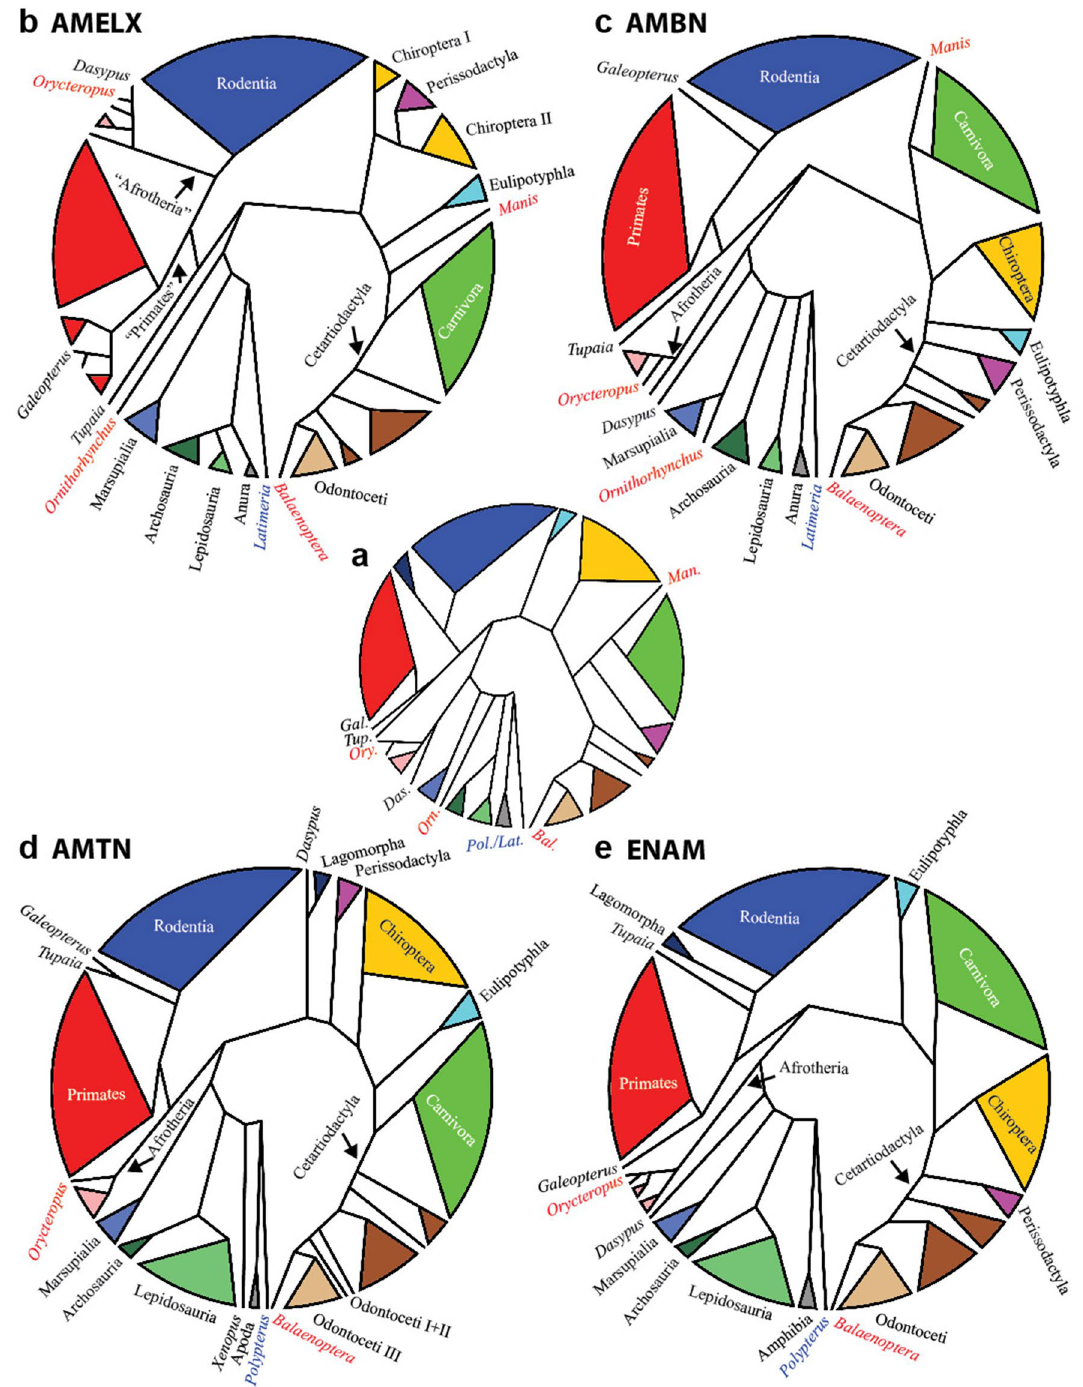
Figure 1. Schemes of unrooted, majority consensus trees of four major enamel matrix proteins. General phylogenetic consensus (www. timet ree. org 2021/07/27) as a scheme in the center ( a ) and schematic phylograms for Amelogenin (AMELX— b ), Ameloblastin (AMBN— c ), Amelotin (AMTN— d ), and Enamelin (ENAM— e ) are displayed highlighting clustering of protein sequences to higher taxonomical groups. Enamel- and toothless species in red, the most basal species (i.e. Latimeria or Polypterus ) in blue. Clusters in bracelets or with a Roman number (I, II, III) are not homogenous in the analysis. There is great stability not only of major taxonomic groups and general tree topology, but also the absence of enamel does not influence the position of the species. Colors correspond to taxonomic clades: Amphibia (dark grey), Lepidosauria (green), Archosauria (dark green); Marsupialia (sea blue), Afrotheria (pink), Primates (red), Lagomorpha (dark blue), Rodentia (blue), Eulipotyphla (light blue), Chiroptera (yellow), Carnivora (light green), Perissodactyla (violet), “Artiodactyla” (brown), Odontoceti (light brown). Full phylograms are in Supplementary Fig.